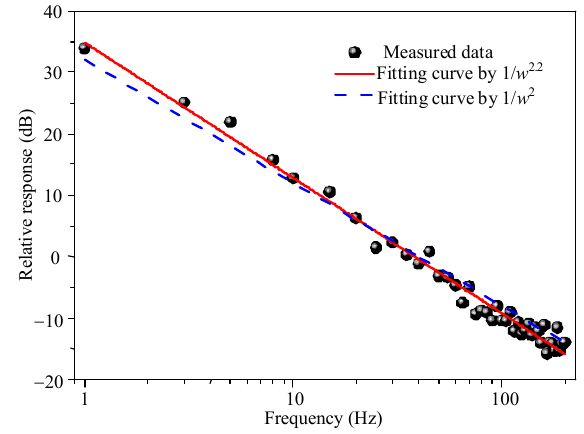
Fig. 4 Response of the proposed scheme relative to that of the conventional accelerometer based